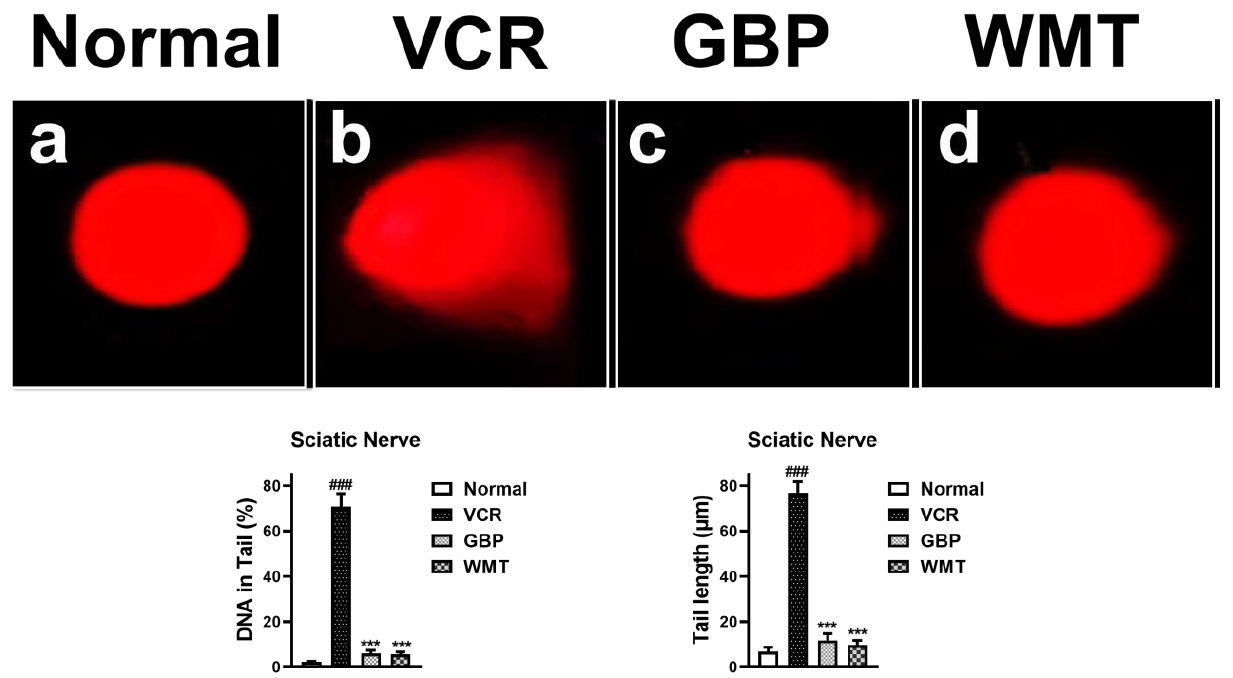
Figure 10. Effect of the WMT treatment against VCR-induced DNA damage of the sciatic nerve. Normal ( a ), VCR ( b ), GBP ( c ), and WMT ( d ). All results were expressed as the mean ( n = 3) ± SD. ### p < 0.001 compared to the normal control group; *** p < 0.001 compared to the VCR group.